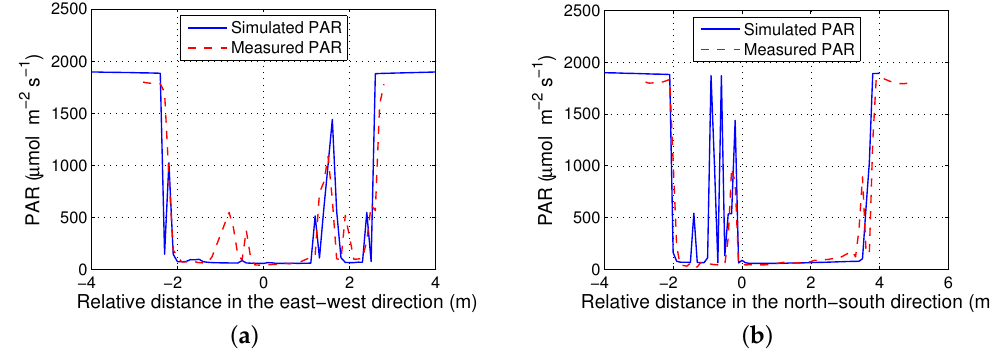
Figure 11. The simulated and measured below-canopy PAR for the RIT Ash Tree: ( a ) along the east–west direction; ( b ) along the north–south